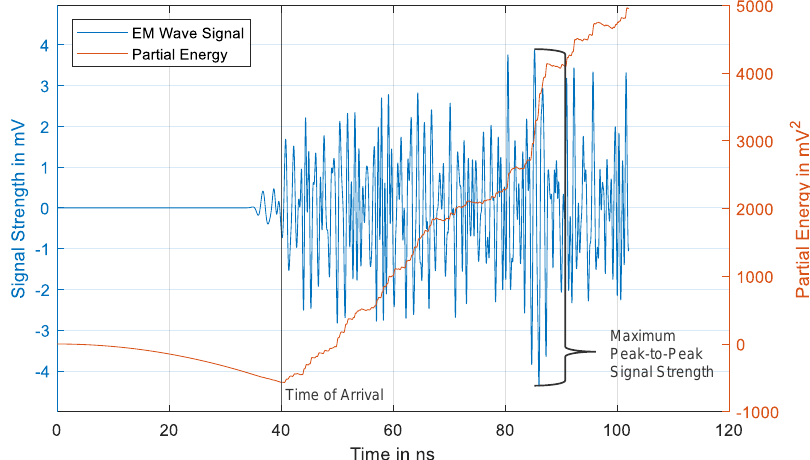
Figure 8. The time-domain signal received by a UHF sensor during a simulation run with the partial energy curve.